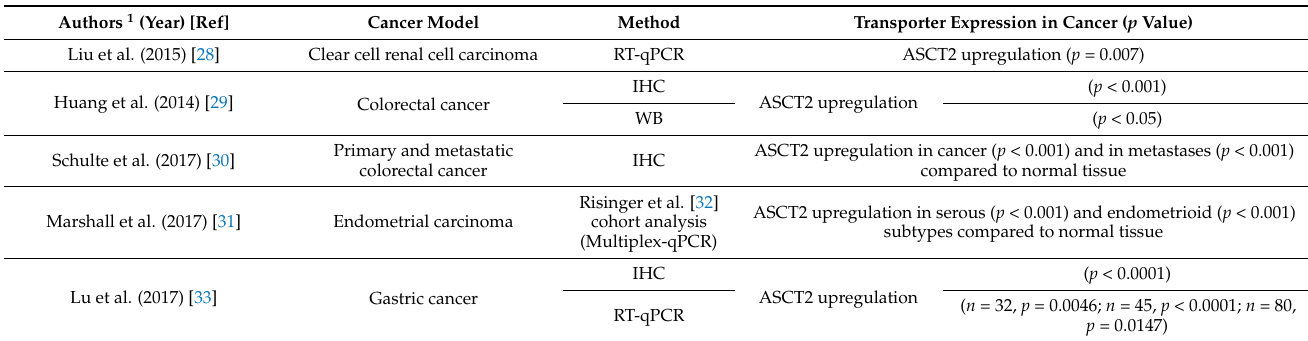
Table 1. ASCT2 and LAT1 expression in